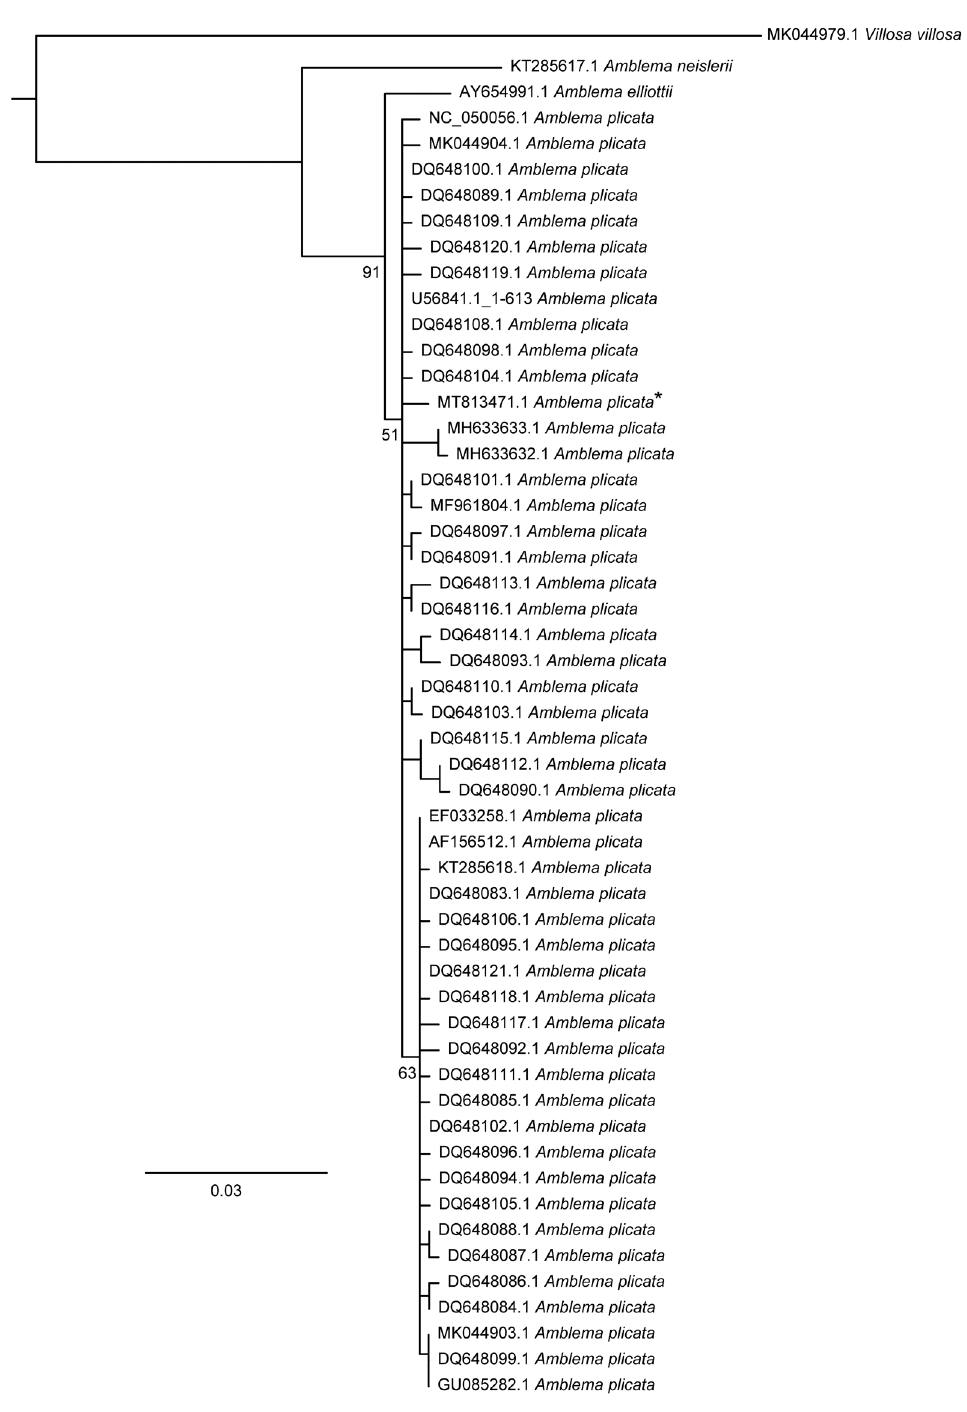
Figure 3. Maximum likelihood phylogeny showing the relationships of the newly generated sequence with the top 52 matches from the NCBI BLASTN search results performed on 20 April 2021. Bootstrap support values are provided for major clades and the query sequence (MT813471) is denoted with an asterisk